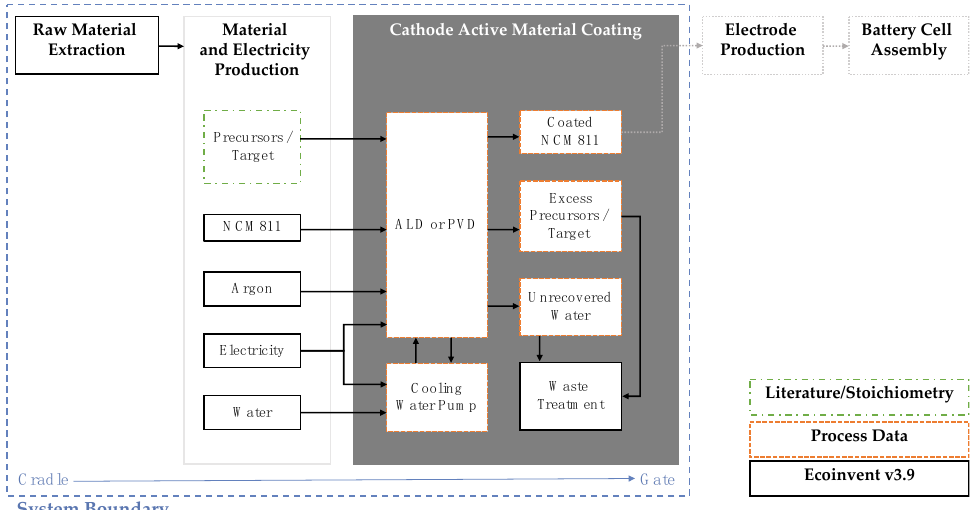
10 of 23 Table 4. Stepwise Average Power Consumption for PVD/MS Process. Step